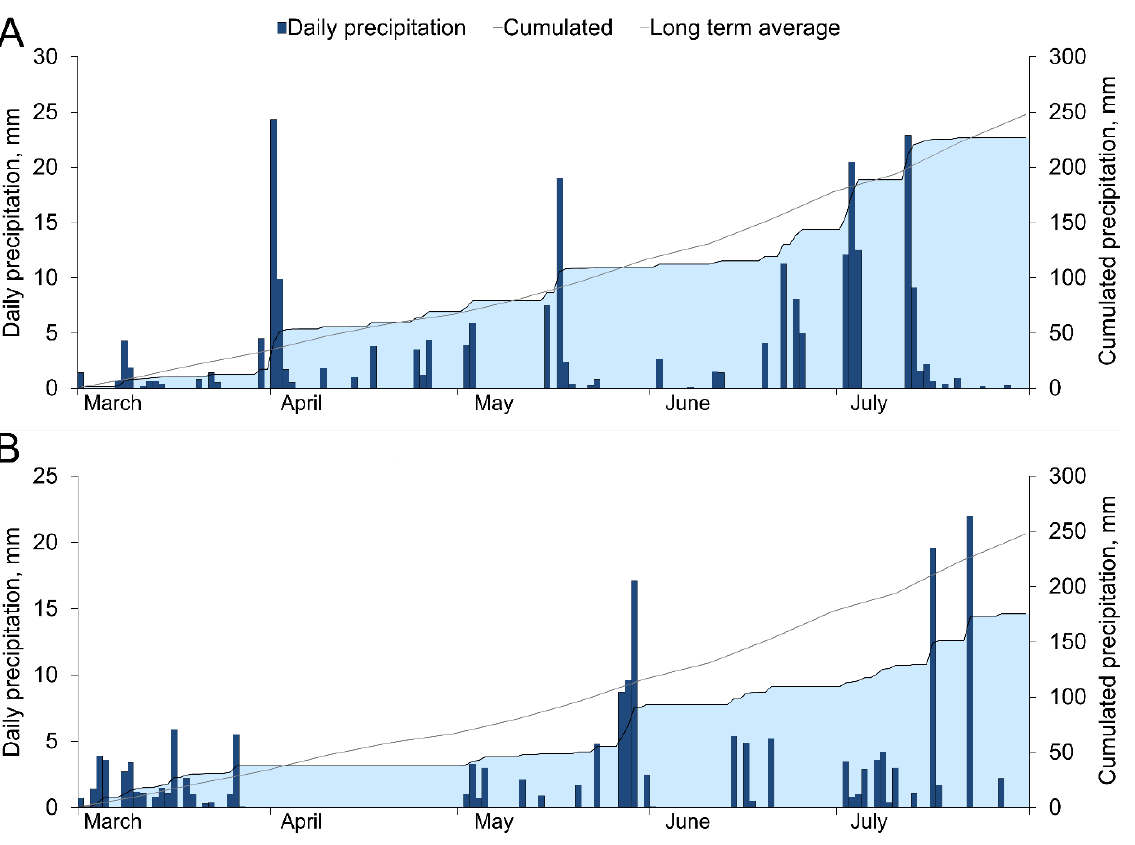
Figure 2. Average daily temperatures during growing seasons of 2017–2018 ( A ) and 2018–2019. Daily and cumulated precipitation at the experimental site (Dotnuva meteorological station, Lithuania) from 1st March to July 31st of 2018 ( A ) and 2019 ( B ).